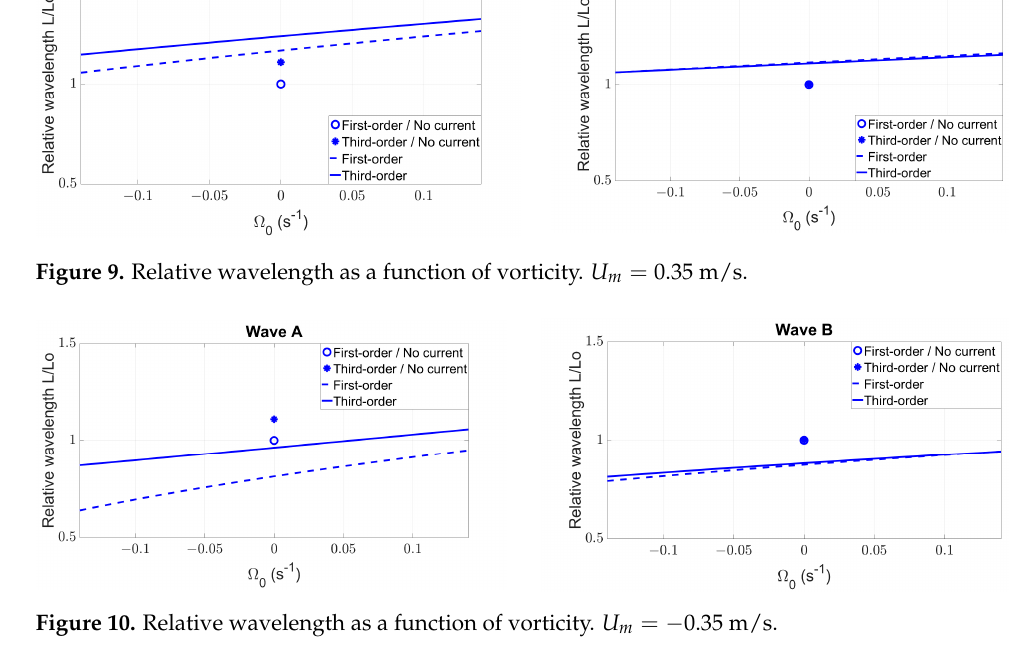
Figure 12. 𝛤 (stream function coefficient) and 𝛬 (surface elevation coefficient) of the n2m-negative interaction component as functions of current velocity at the mid-depth.